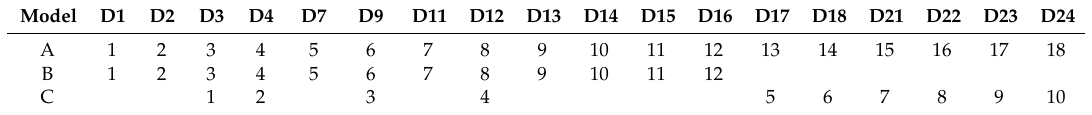
Table 6. The case studies and the variables that were included 1